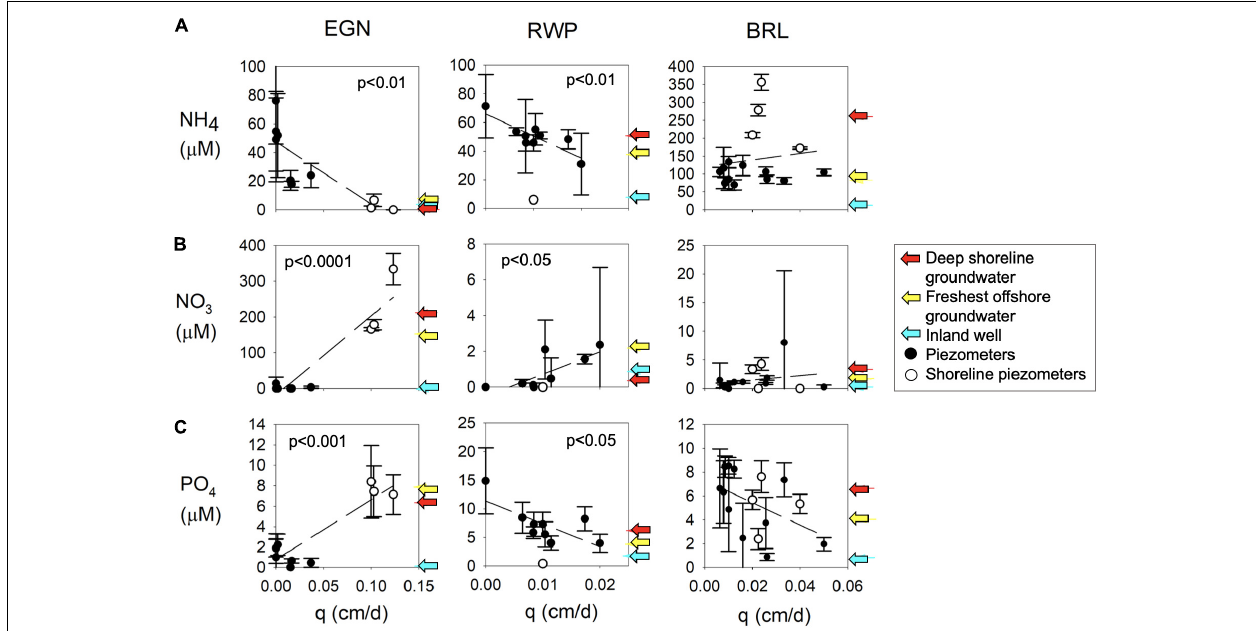
FIGURE 5 | Relationship between specific discharge (q) and average (A) NH 4 concentrations, (B) NO 3 concentrations, and (C) PO 4 concentrations in individual piezometers from each sampling trip. Y-error bars represent the standard deviation of nutrient concentrations. The average concentrations of putative freshwater sources are shown with arrows. Dashed lines indicate a linear regression between q and concentrations. P -values are only reported for regressions where the relationship was significant at p < 0.05.